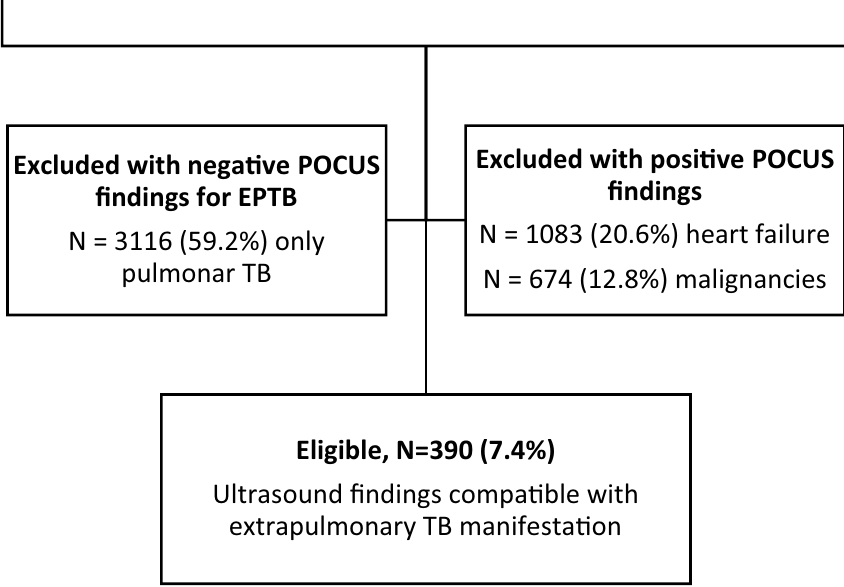
Figure 1. Extrapulmonary tuberculosis (TB) in-patient flowchart from Carmelo Hospital of Chókwè